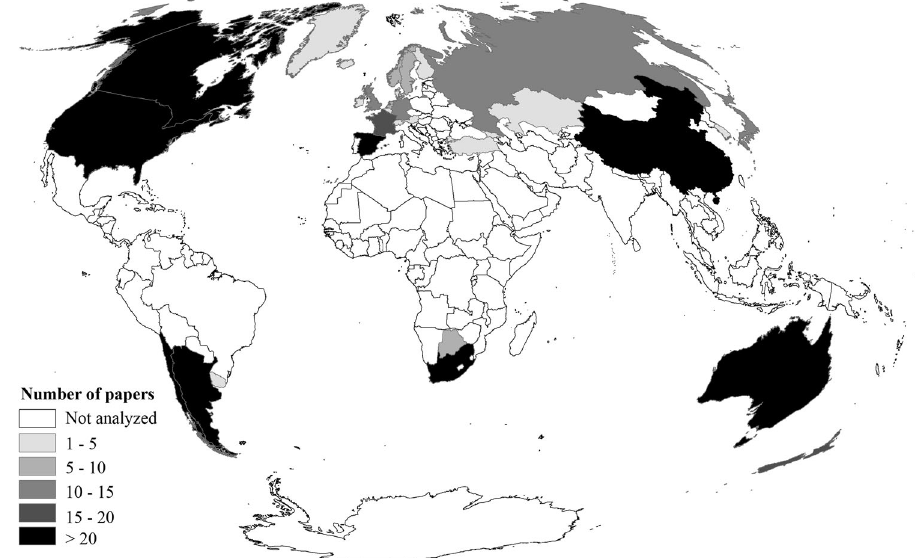
Fig. 3 Countries with the highest number of socio-ecological scienti fi c papers ( n = 467